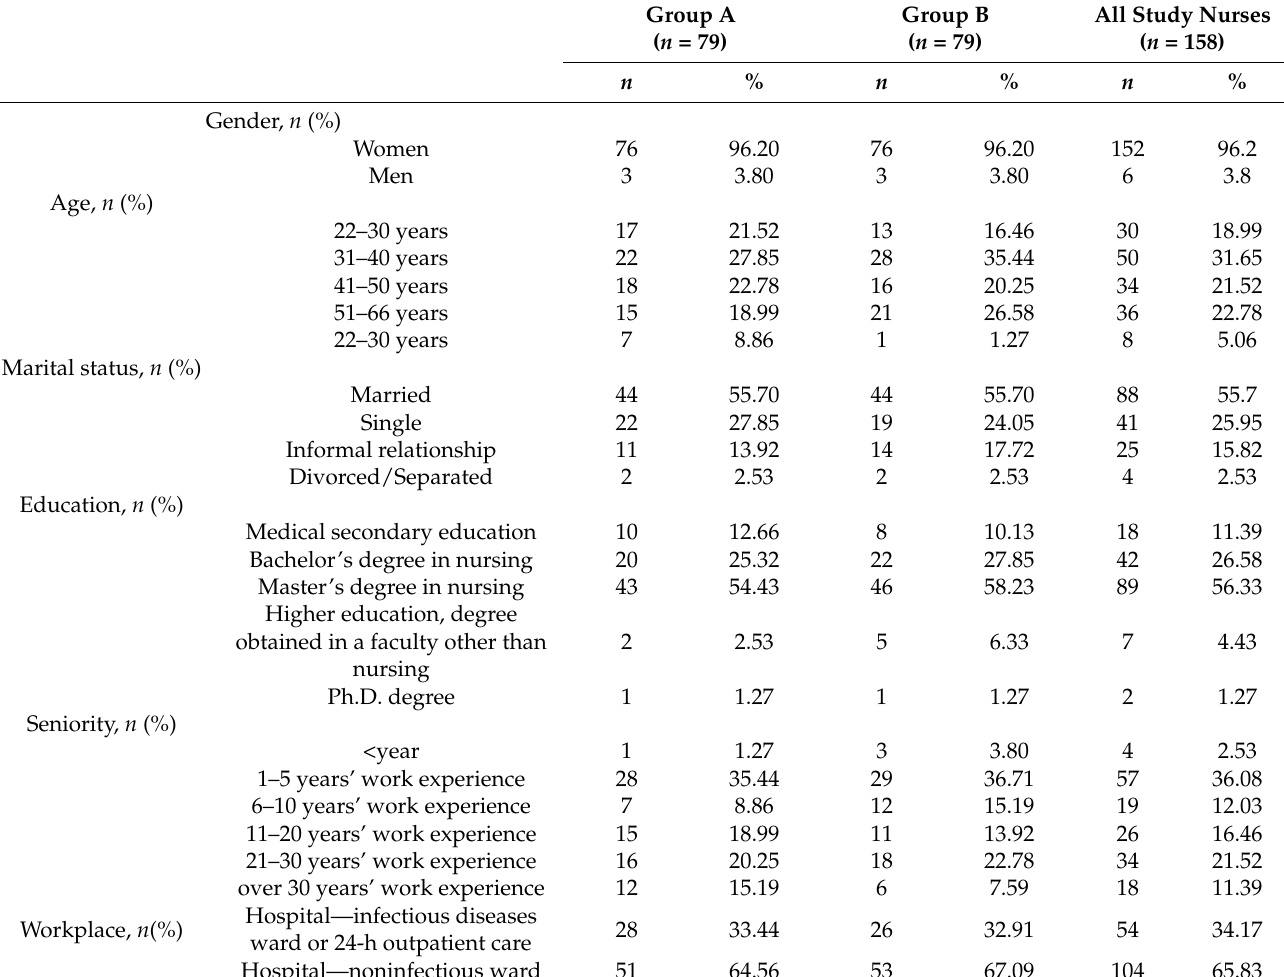
Table 1. Description of the researched